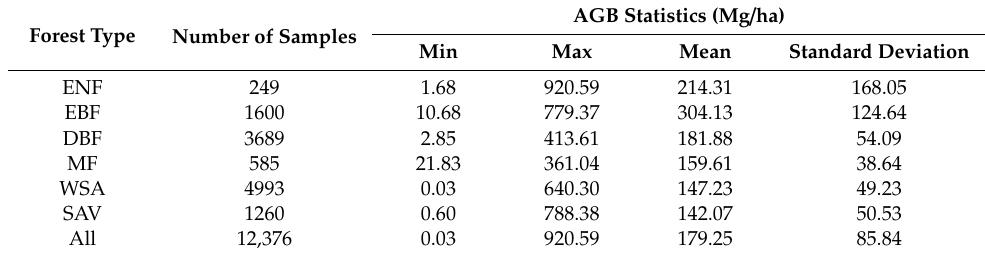
Table 1. Statistics of the reference AGB samples used in this